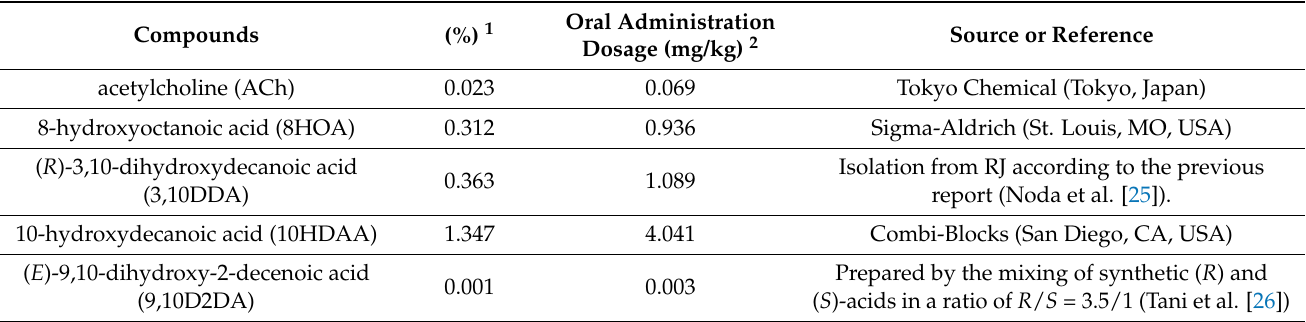
Table 1. The composition of the enzyme-treated royal jelly (ETRJ) and source or reference of the compounds used in this